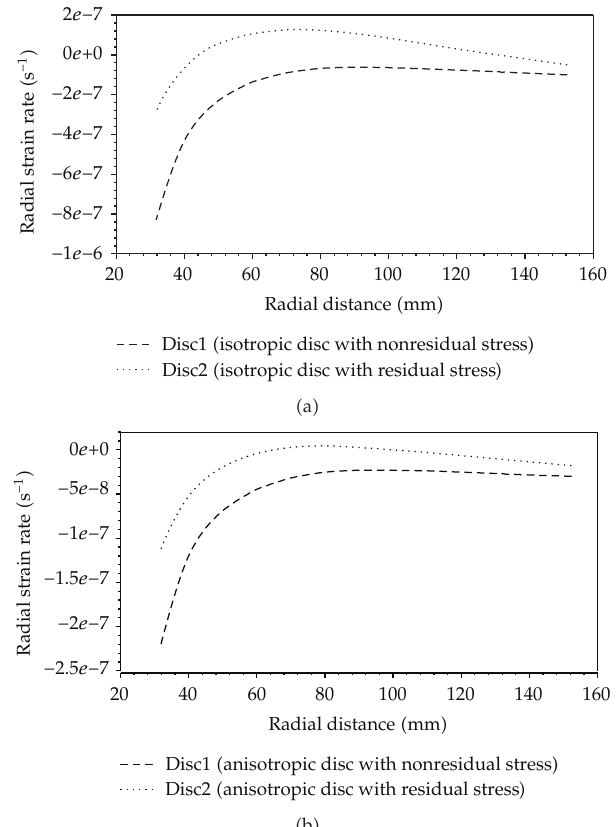
Figure 6: Variation of radial strain rate along the radial distance in isotropic/anisotropic discs rotating with an angular velocity 15000rpm at